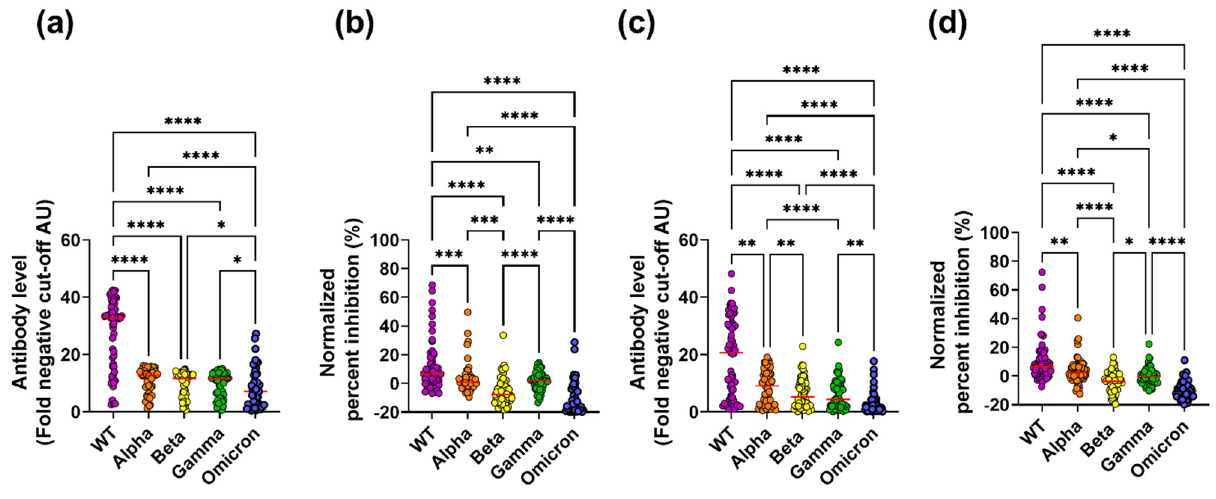
Figure 1. RBD-specific IgG levels and ACE2 inhibition for SARS-CoV-2 WT and four VoCs in symptomatic and paucisymptomatic subjects. RBD-specific IgG binding (( a , c ) (antibody level, fold negative cut-off AU)) and ACE2 inhibition (( b , d ) (normalized percent inhibition)) against the WT, Alpha, Beta, Gamma, and Omicron variants was measured in subjects with severe symptoms ( a , b ) and paucisymptomatic subjects ( c , d ). A Freidman test with Dunn post-hoc test was performed between all possible combinations (* p = 0.05, ** p = 0.01, *** p = 0.001, ****, and p = 0.0001).